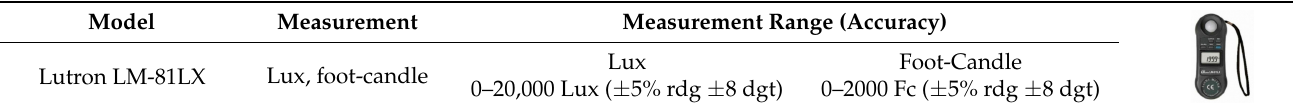
Table 7. Specifications of photometer (Luton LM-81LX).